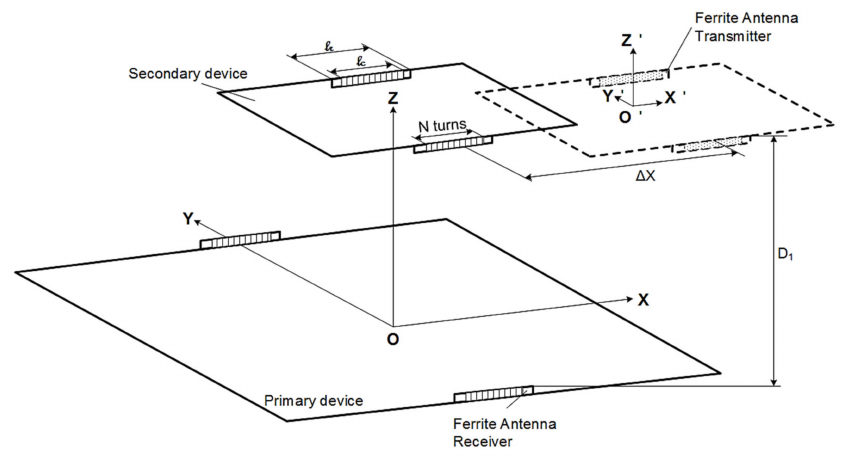
Figure 13. Diagram for finding center alignment point in the electric vehicle (EV) wireless power transfer (WPT) system.